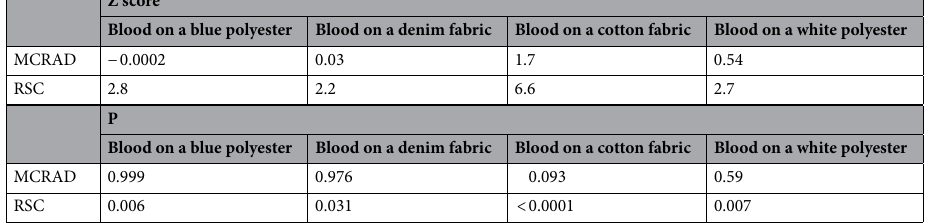
Table 1. Estimations of the Z score and the confidence probability P of the blood absence in the sample set of blood stains on various substrates.